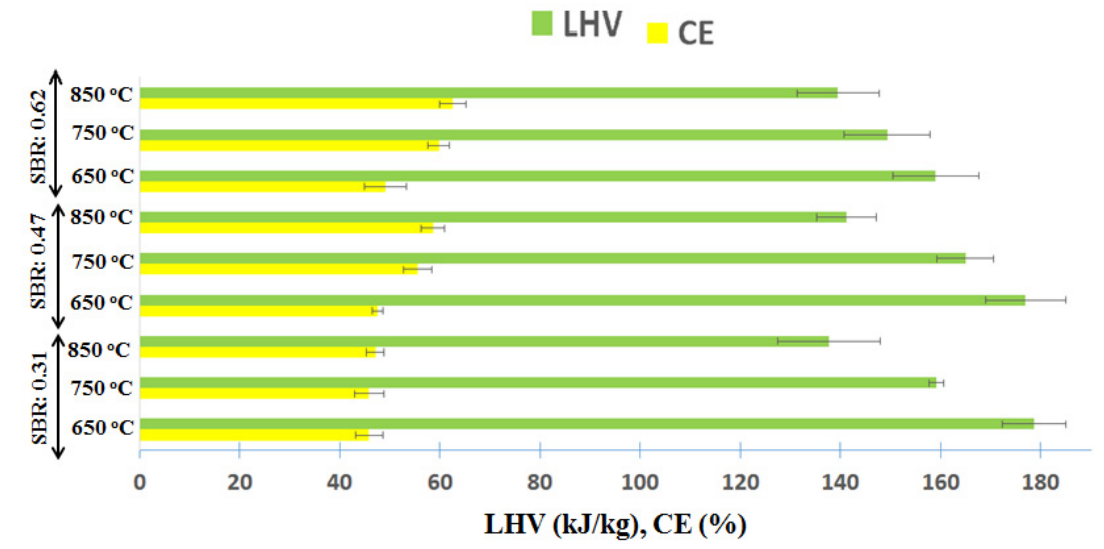
Figure 3. Lower heating value and carbon efficiency for the steam gasification of fuel pellets at different gasification temperatures and steam-to-biomass ratios.